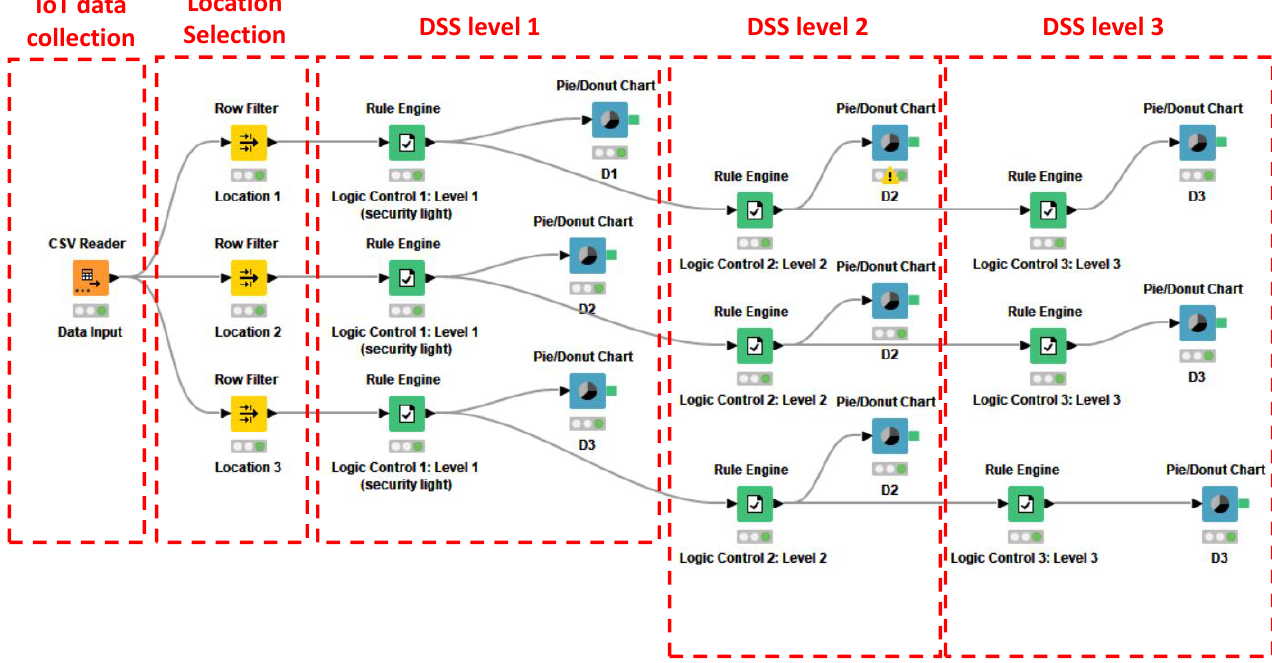
Figure 3. KNIME workflow model based on threshold checking and implementing three-DSS levels for worker safety control. The workflow executes the open dataset [15]. The horizontal flux of the KNIME workflows model the vertical BPMN structure of Figure 2.